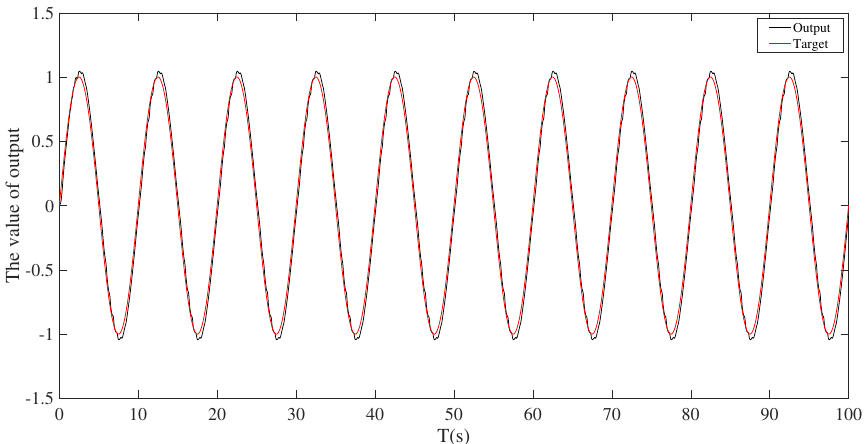
Figure 1. Output and target curves in known time-varying delay form (with dead-zone compensation controller).